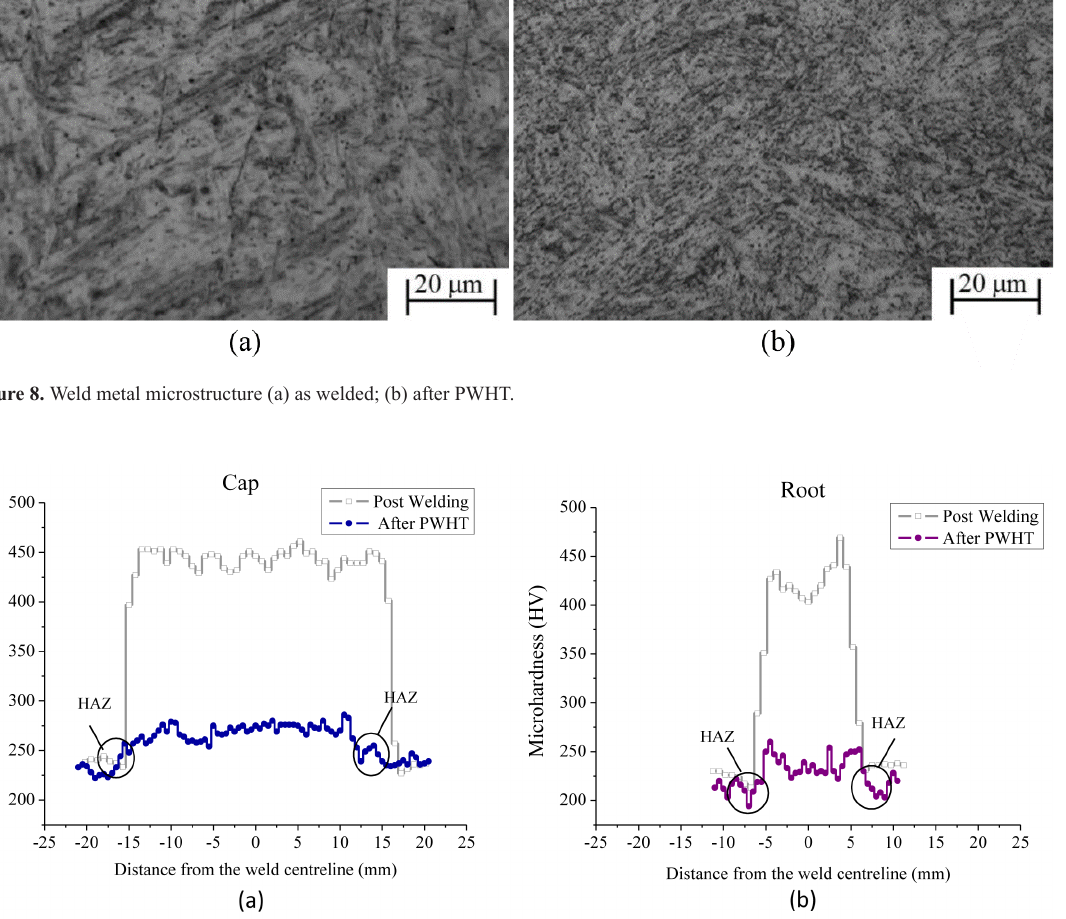
Figure 9. Microhardness of welded joints (a) Cap; (a)